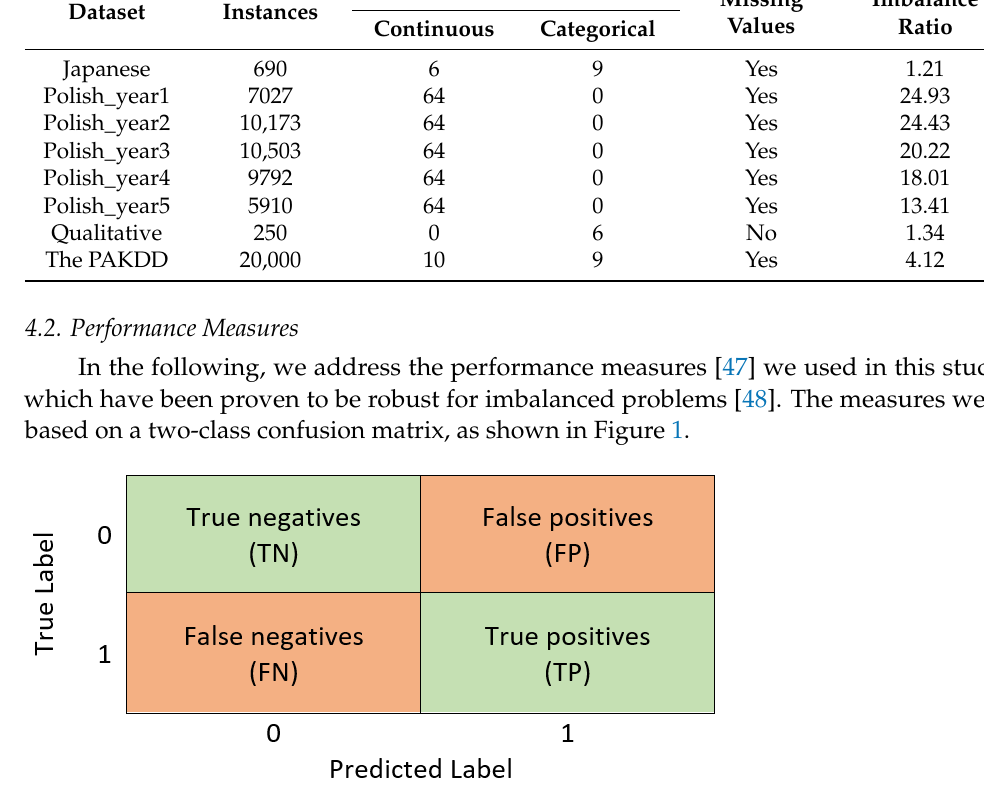
Figure 1. Confusion matrix for a two-class problem.